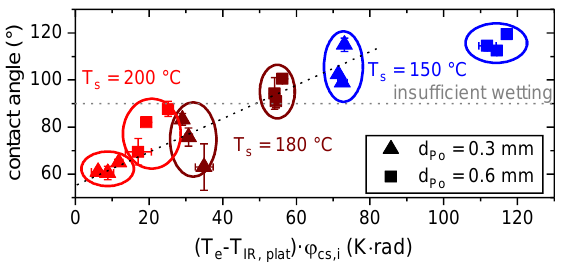
Figure 13. Contact angle as a function of thermographic determined plateau temperature, T IR, plat , and the preset contact angle, φ cs,i , (cf. Equation (4)).